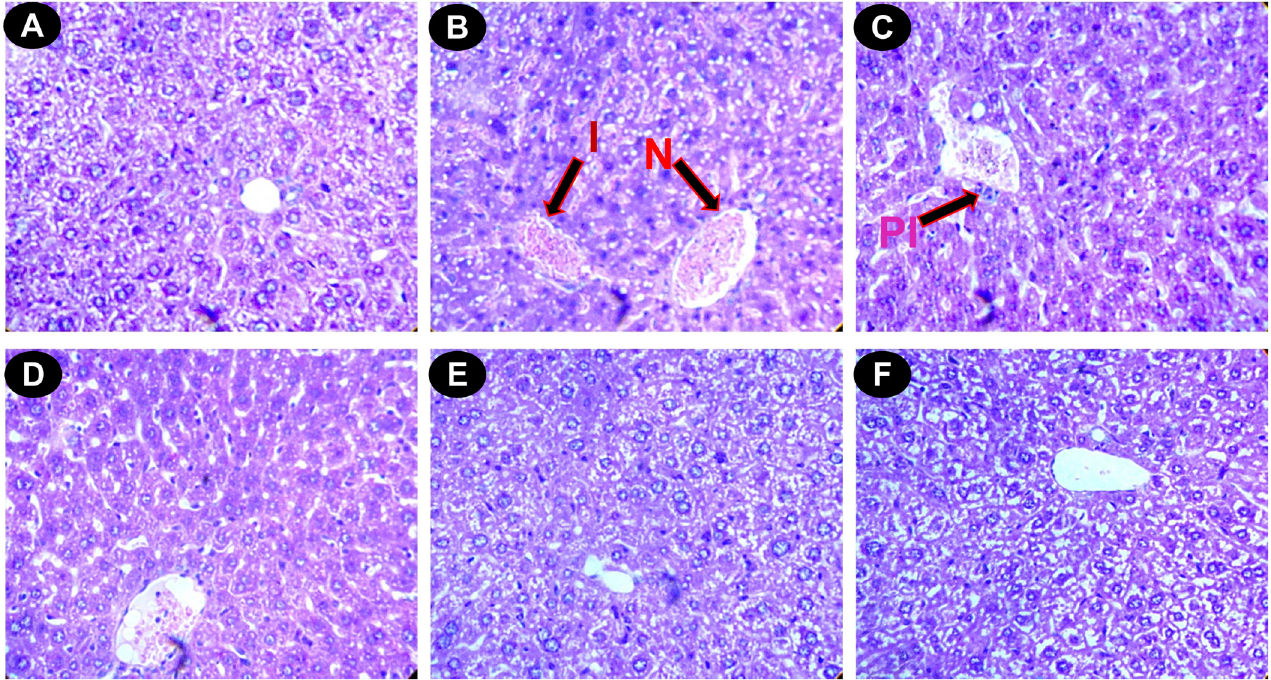
Fig 7. Photomicrograph of mice liver sections (staining with haematoxylin and eosin) ×400. (A) Control mice liver shows normal cellular integrity. (B) Iron-intoxicated (iron dextran, 100 mg/kg b.w.) liver section showing necrosis (N) , fatty ballooning degeneration, inflammation (I) , and loss of cellular boundaries. (C) Liver section treated with iron dextran + 50 mg/kg b.w. DBME shows improved histology with portal inflammation (PI) . (D) Liver section treated with iron dextran + 100 mg/kg b.w. DBME. (E) Liver section treated with iron dextran + 200 mg/kg b.w. DBME. (F) Liver section treated with iron dextran + 20 mg/kg b.w. desirox shows reduced necrotic area and the increased number of hepatocytes. S100 and S200 show reduced hepatocellular necrosis, ballooning degeneration, and inflammation indicating a trend of restoration of normal cellular